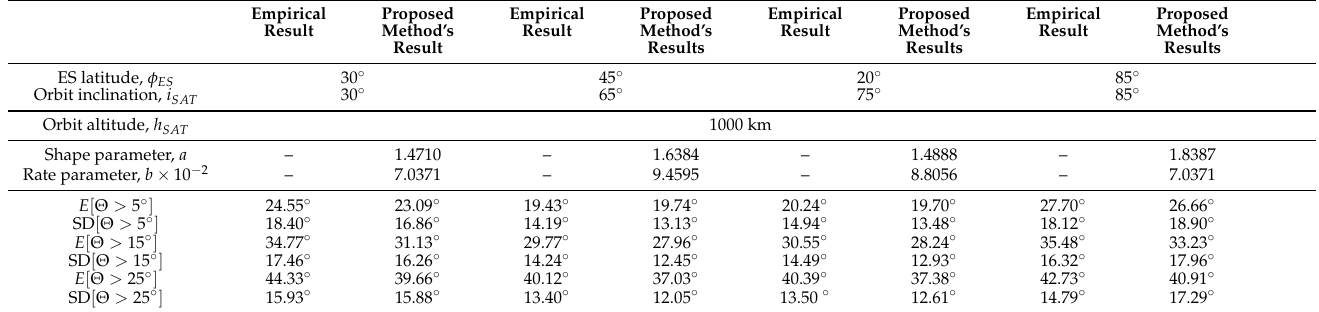
Table 8. First and second order statistics of the elevation angle for the same orbit configurations and ES’s locations that in Figure